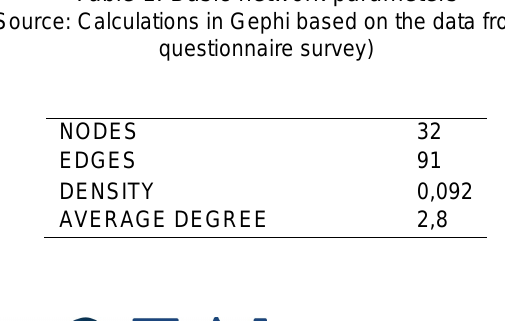
Table 2. Geographical localisation of